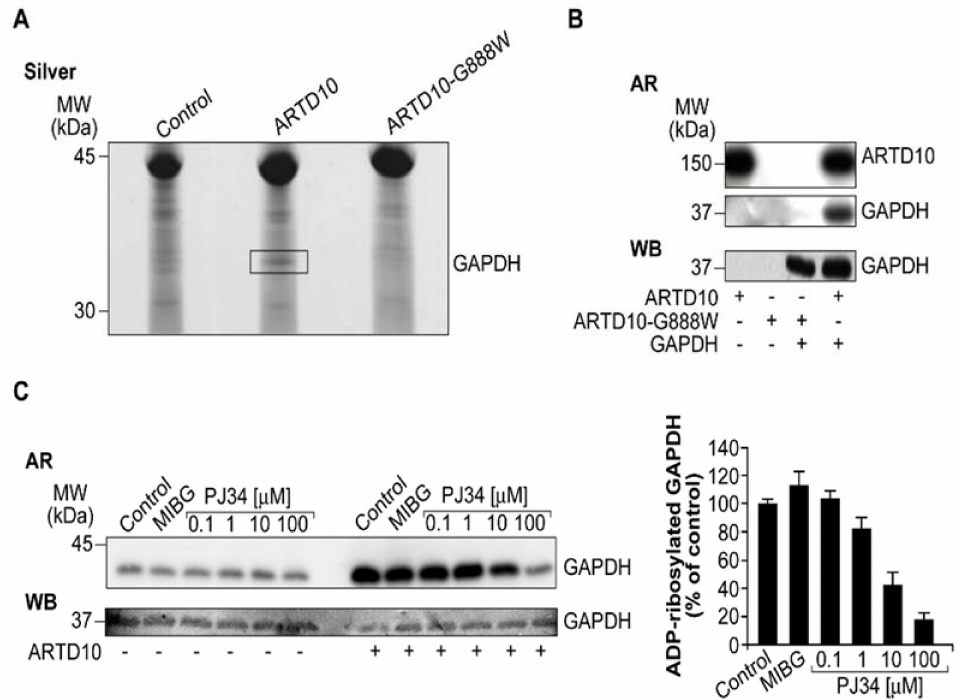
Figure 2. ARTD10/PARP10 ADP-ribosylates GAPDH . ( A ) Representative pull-down assay from CHO cells transfected with an empty vector (control) or with HA-tagged ARTD10 or ARTD10-G888W. Cell lysates (2 mg protein) underwent a non-specific pull-down step using the GST-tagged m Af1521/G42E mutant (with abrogated binding of m Af1521 ADP-ribosylated proteins). The unbound material underwent a second pull-down with GST- m Af1521 wt, to specifically retain ADP-ribosylated proteins. This two-step procedure resulted in separation of specific proteins that were revealed by colloidal Coomassie blue staining and identified by MALDI-TOF analysis; ( B ) GAPDH was [ 32 P]-ADP-ribosylated in vitro for 1 h at 37 ◦ C in the presence of ARTD10 or ARTD10-G888W, separated by SDS-PAGE, and analysed by autoradiography (AR). Recombinant GAPDH is shown by immunoblotting with an anti-GAPDH antibody. The data shown are representative of four independent experiments; ( C ) GAPDH was [ 32 P]-ADP-ribosylated in vitro for 1 h at 37 ◦ C in the presence of ARTD10 and MIBG (200 µ M) or increasing concentrations of PJ34 (0.1–100 µ M), separated by SDS-PAGE, and analysed by autoradiography (AR). Recombinant GAPDH is shown by immunoblotting with an anti-GAPDH antibody. Quantification of these representative data of ARTD10-mediated ADP-ribosylated GAPDH (as % modified protein) upon treatment with these inhibitors is shown on the right, with the data expressed as means ± SD from three independent